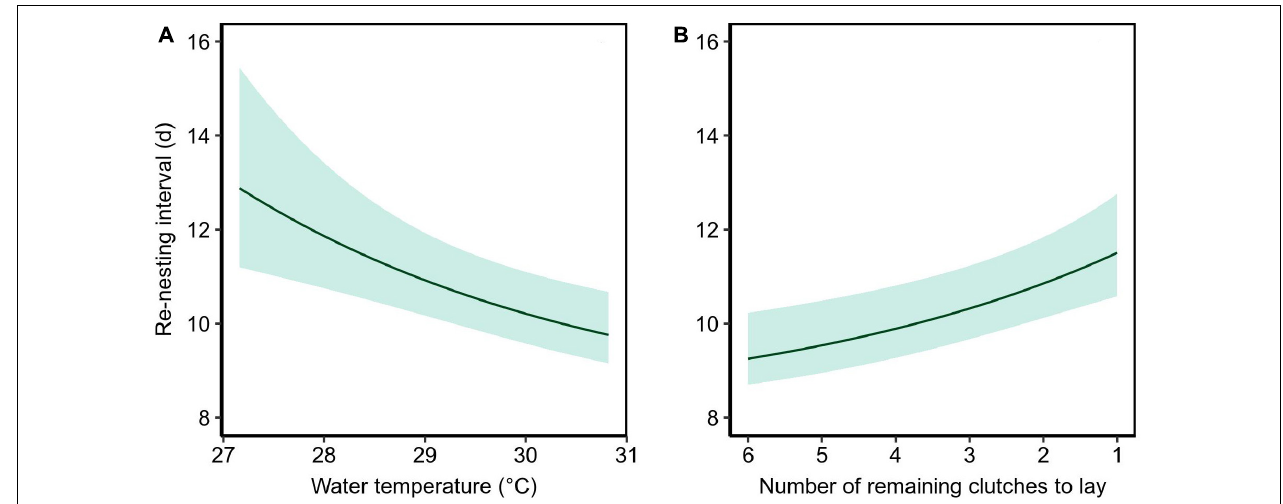
FIGURE 5 | Effects of (A) the water temperature experienced by the turtles and (B) the number of remaining clutches to lay on the re-nesting interval observed from 20 turtles that nested after tag deployment at Jazirat Mashabah ( n = 13) and Ras Al Baridi ( n = 7). Each solid line represents the estimated relationship when held at the other covariate’s mean with the bands showing the 95% confidence intervals.